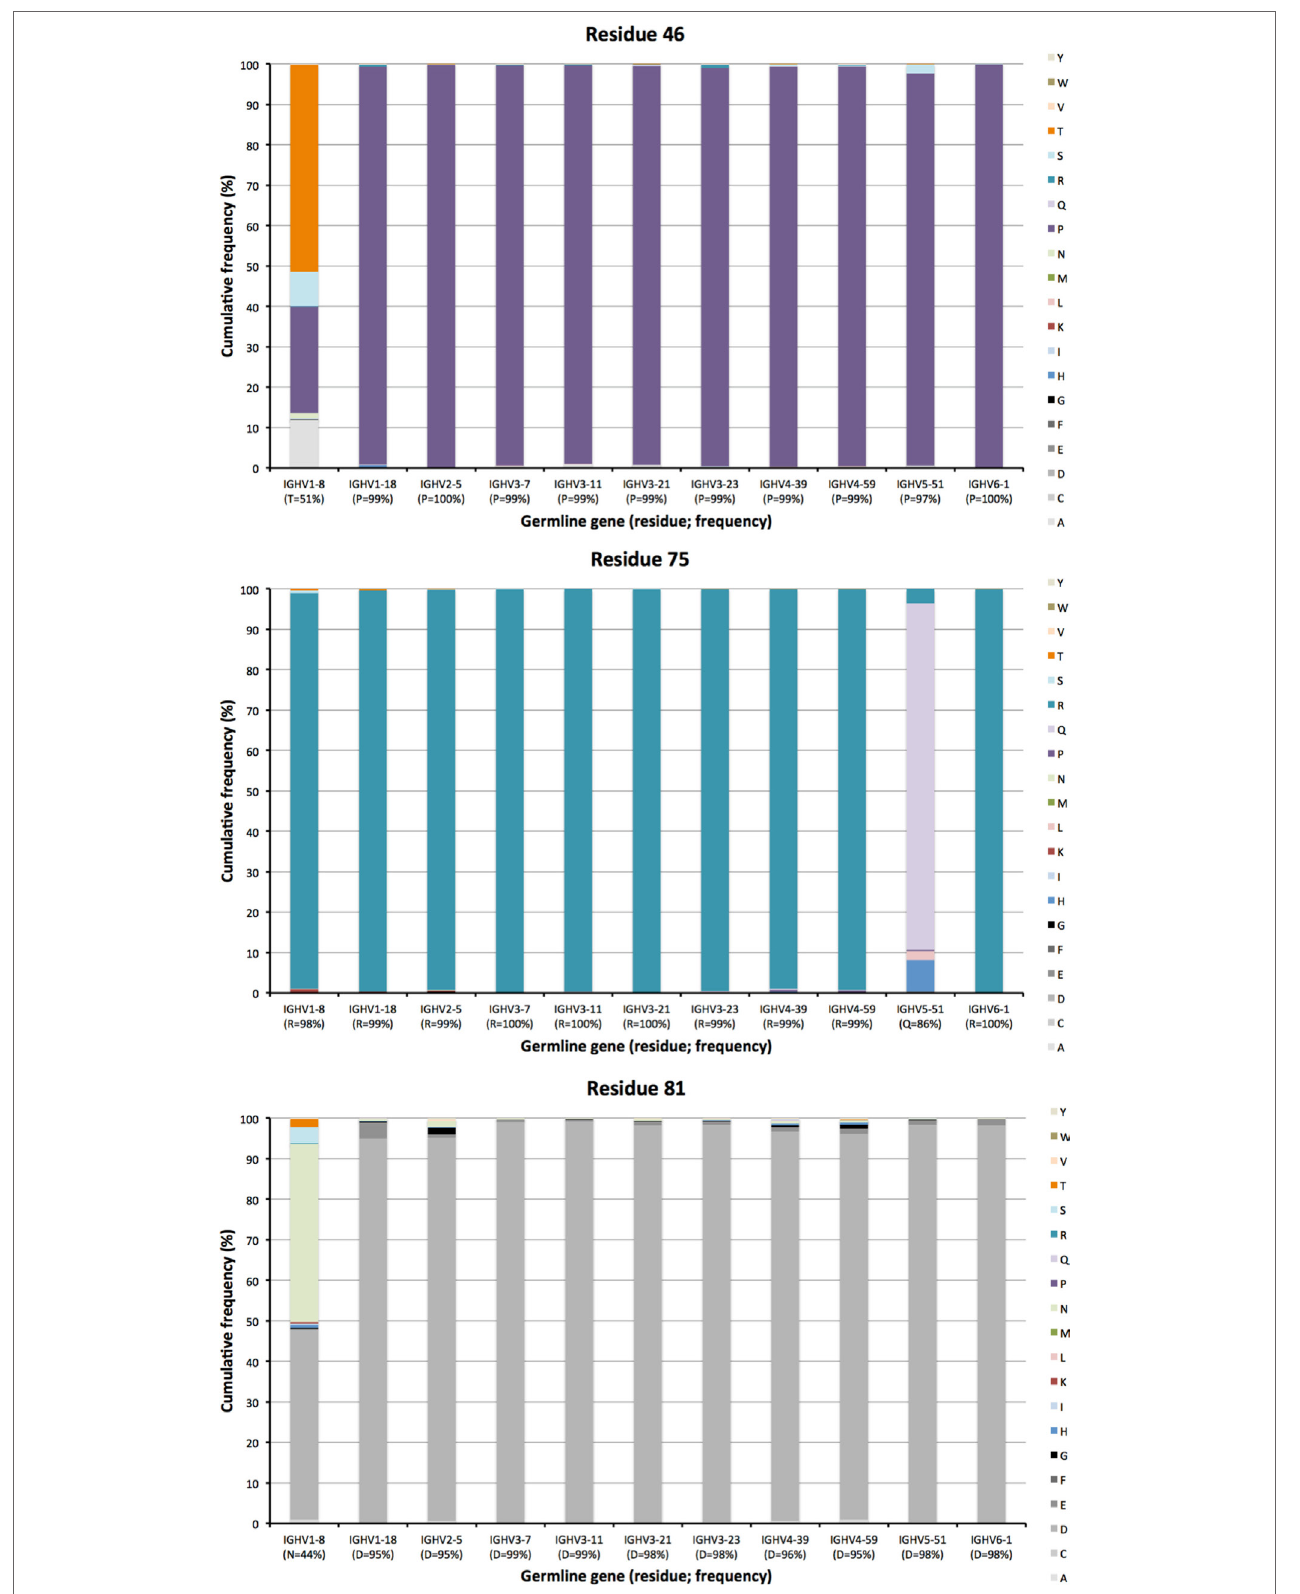
FigUre 11 | Substitutions of residues 46, 75, and 81 as introduced during somatic hypermutation processes of IgG-encoding genes derived from 11 different germline genes.